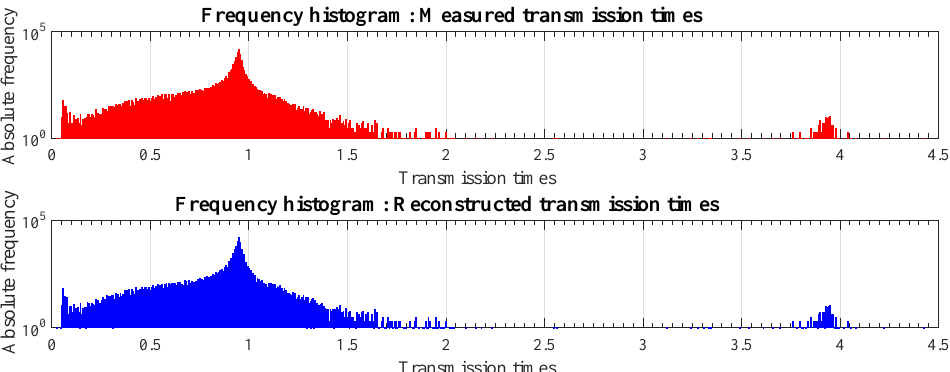
Figure 19. Measured and reconstructed transmission times frequency histogram (using log scale on x - and y